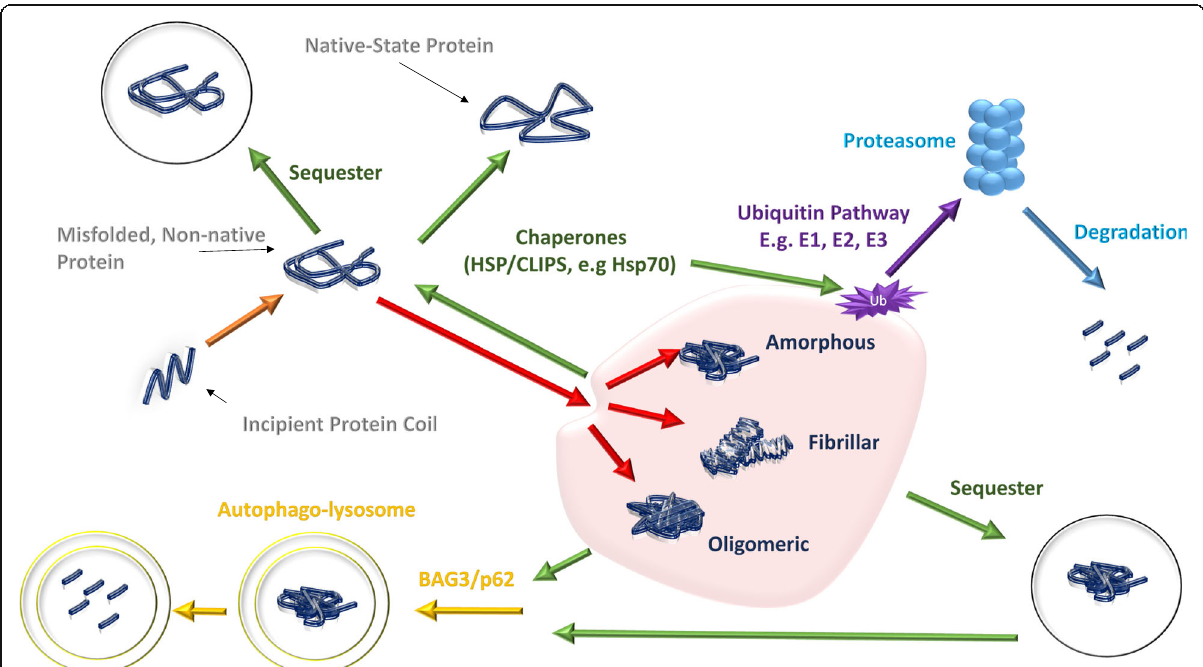
Fig. 1 Quality Control of Misfolded Proteins. Green arrows denote chaperone pathways. When a misfolded protein occurs, it can be detected by a molecular chaperone and refolded into a native protein. If this process cannot be completed, either because the native protein is unable to undergo further conformational change or because it has formed an aggregate, it can be sequestered and degraded at a later stage. When protein aggregates form in either an amorphous, fibrillary or oligomeric state, chaperone proteins can initiate two destruction responses. They can target them for destruction via the Ubiquitin-proteasome pathways by facilitating ubiquitin tagging, or facilitate action via BAG3/p62 them for autophagal degradation. ER = Endoplasmic Reticulum; E1 = ubiquitin – activating enzymes; E2 = ubiquitin – conjugating enzymes and E3 = ubiquitin ligases. [Based on Reference Hartl [23] and Tofaris & Buckley